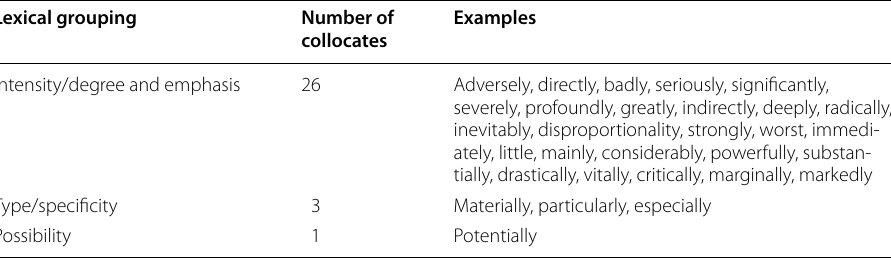
Table 3 Lexical grouping of the adverbial collocates of the verb affect Lexical grouping Number of collocates